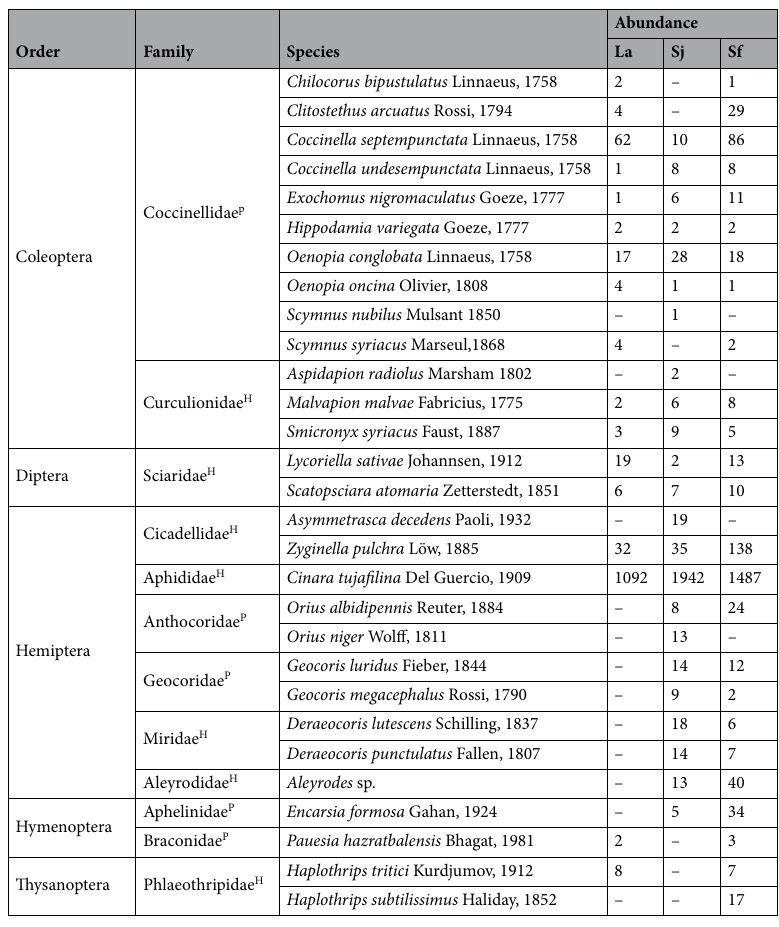
Table 1. Insect species associated with the Chinese thuja trees, Platycladus orientalis (L.) in Lashkar ( La ), Sadaf ( Sf ), and Sajjad ( Sj ), urban green spaces in Mashhad, Iran. Abundance and guilds are provided. H herbivores, P natural enemies that include predators +